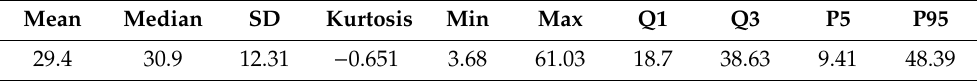
Mean Median SD Kurtosis Min Max Q1 Q3 P5 P95 29.4 30.9 12.31 − 0.651 3.68 61.03 18.7 38.63 9.41 48.39